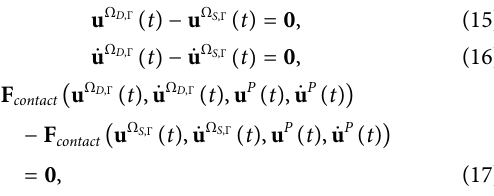
Frontiers in Built Environment |